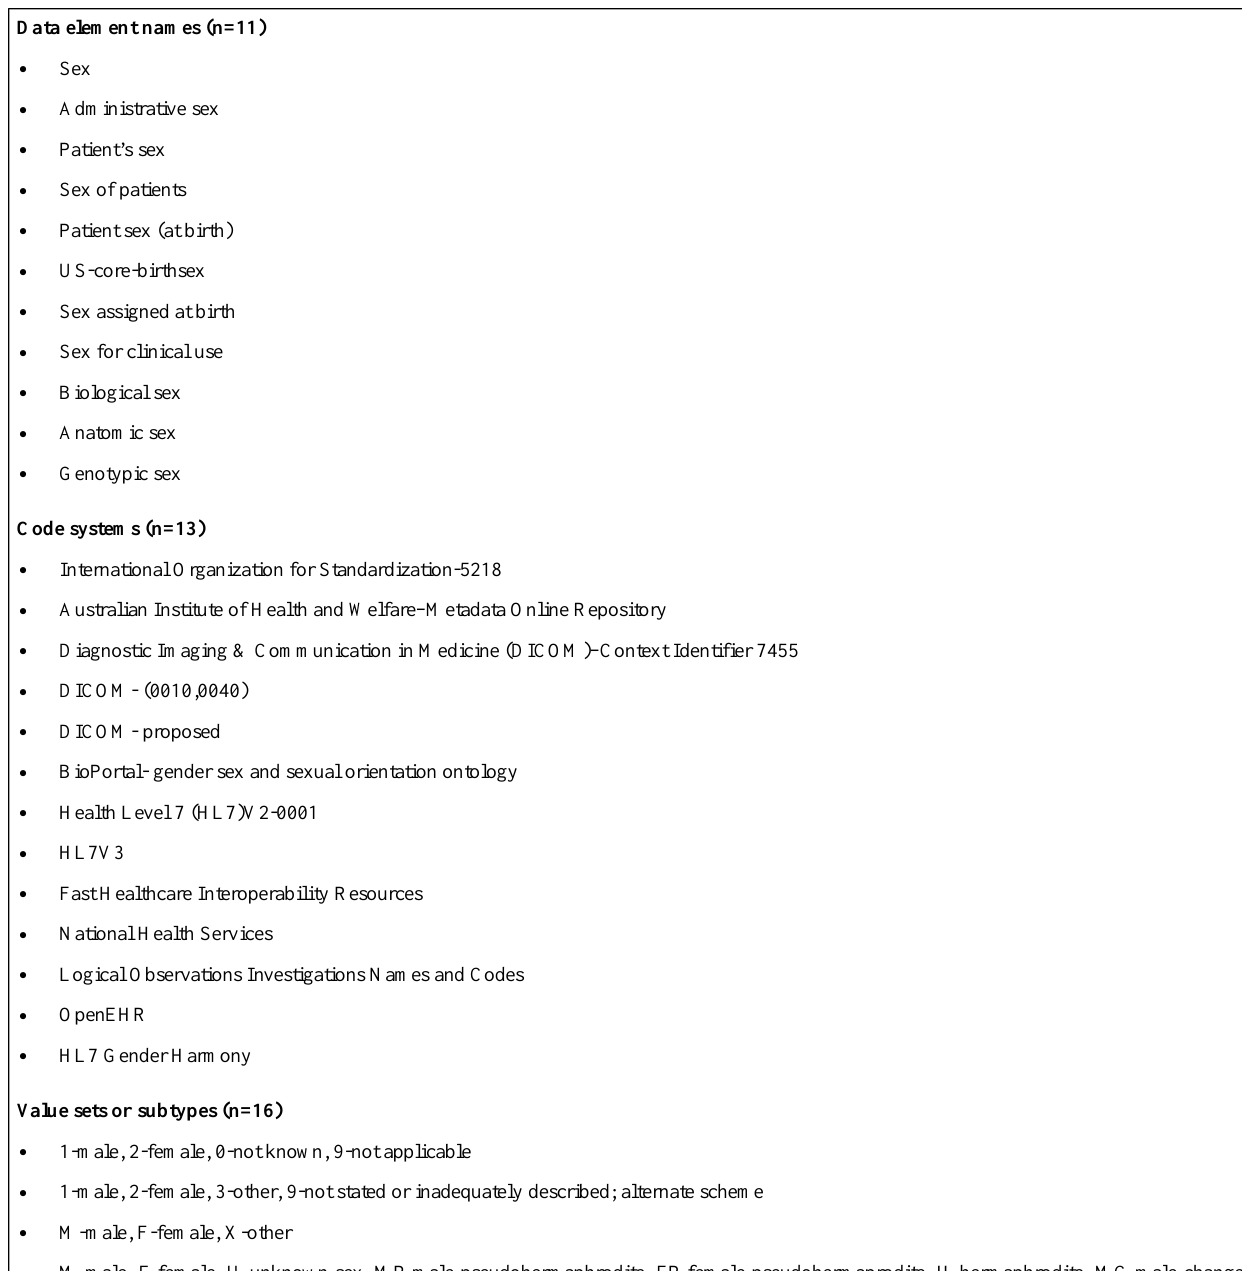
Textbox 3. Summary of definitions for sex-related concepts from standards